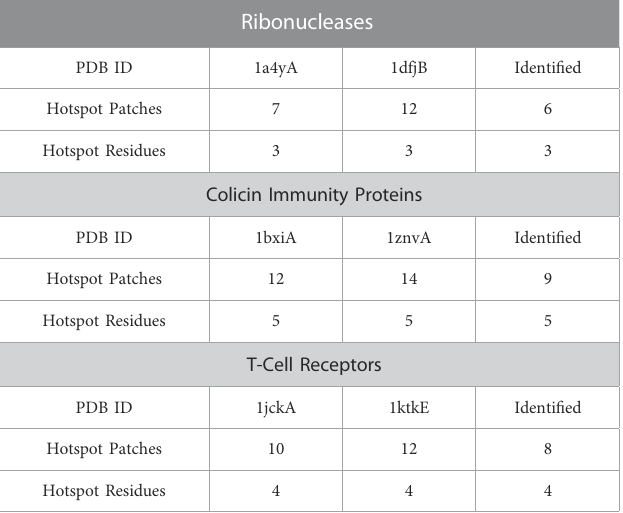
Table 1 summarizes the results of hotspot patch and residue detection by PPI-Surfer. Hotspot residues and patches of RIs are